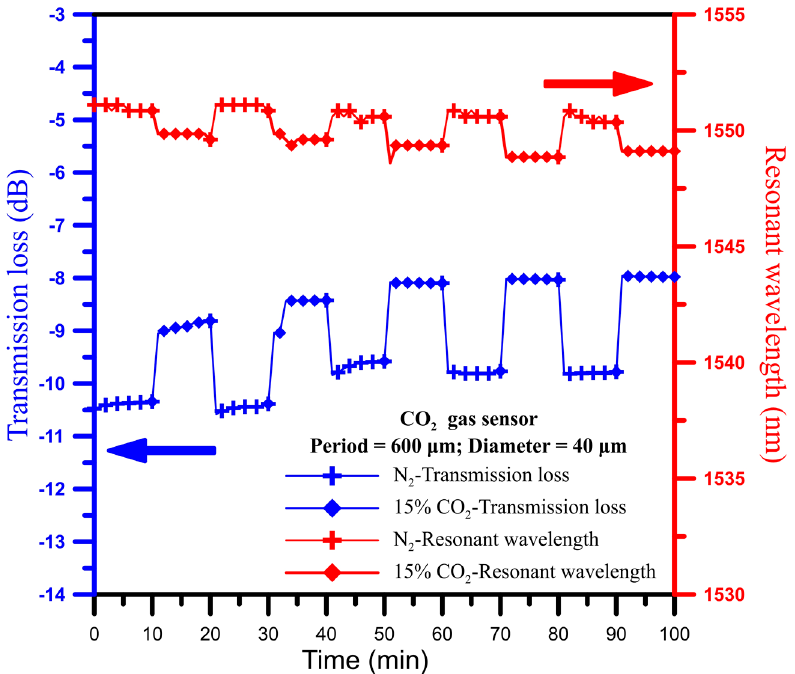
Figure 5. Repeatability of the CO 2 gas sensor spectral analysis.